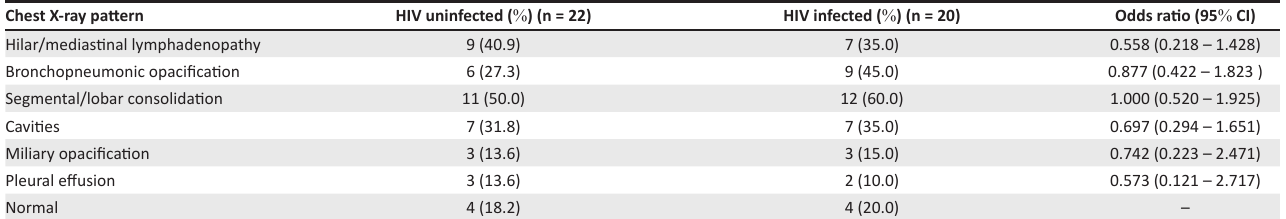
TABLE 3: Comparison of chest X-ray patterns in HIV-uninfected and HIV-infected children. Chest X-ray